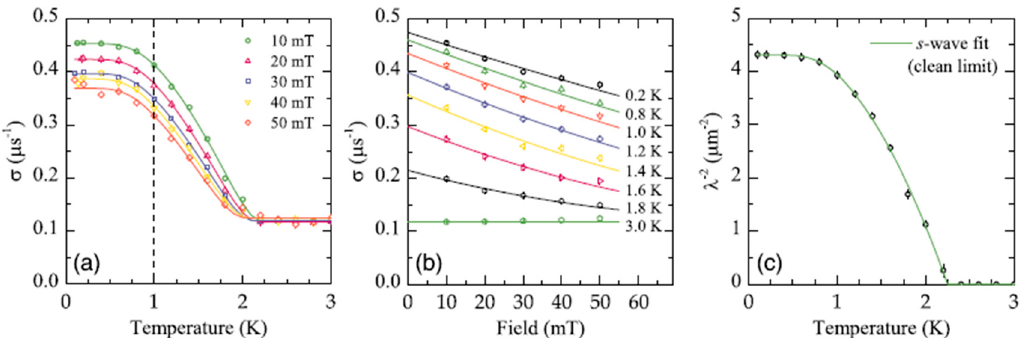
Figure 11. ( a ) Temperature dependence of the TF- μ SR spin-depolarization rate for La 7 Ir 3 in different fields; ( b ) field dependence of the muon spin-depolarization rate at different temperatures; ( c ) temperature dependence of the inverse magnetic penetration depth squared [34].